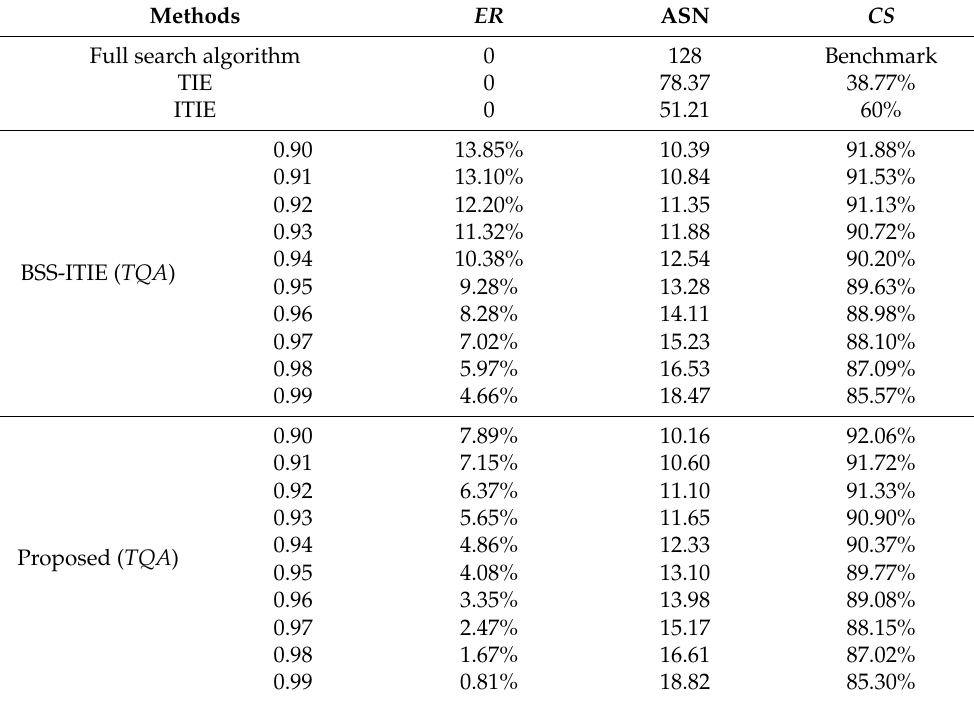
Table 4. Comparison of the computational load and ER of various methods.